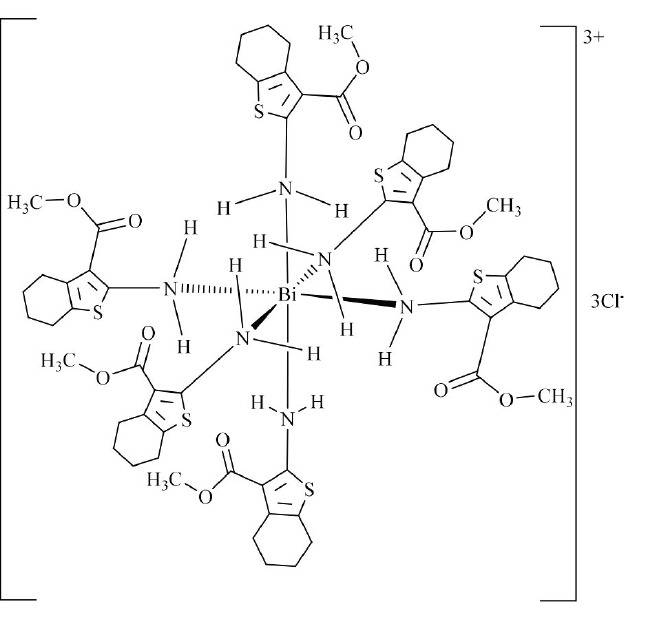
Figure 6. 3D view of the coordination sphere of complex 4 drawn with ACD/Labs 3D viewer (freeware)